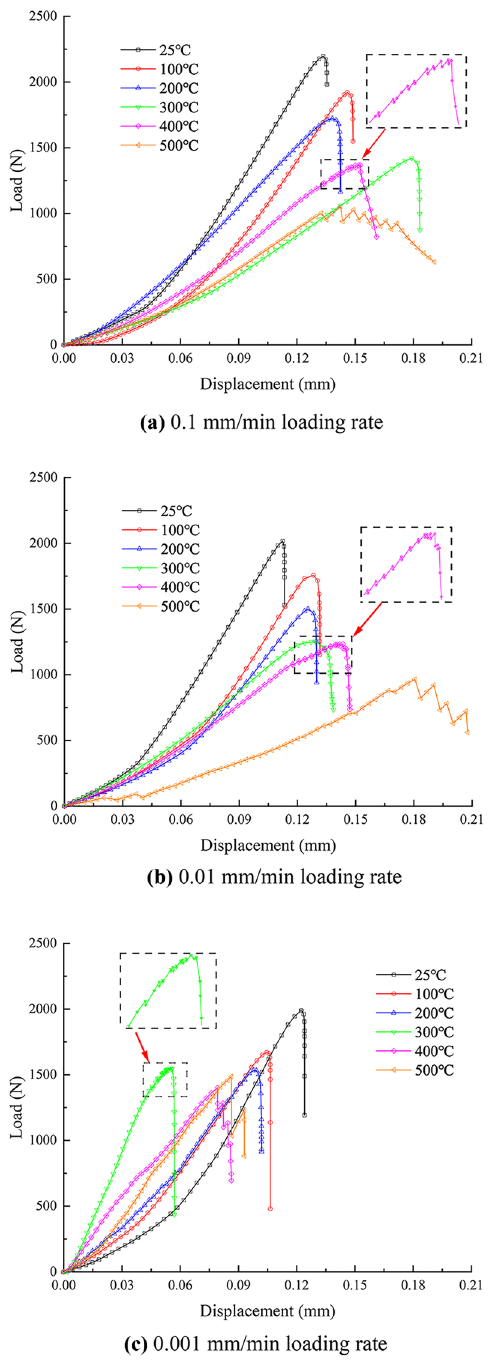
Fig. 4 Load–displacement curves at different temperatures and loading rates. a 0.1 mm/min loading rate. b 0.01 mm/min loading rate. c 0.001 mm/min loading